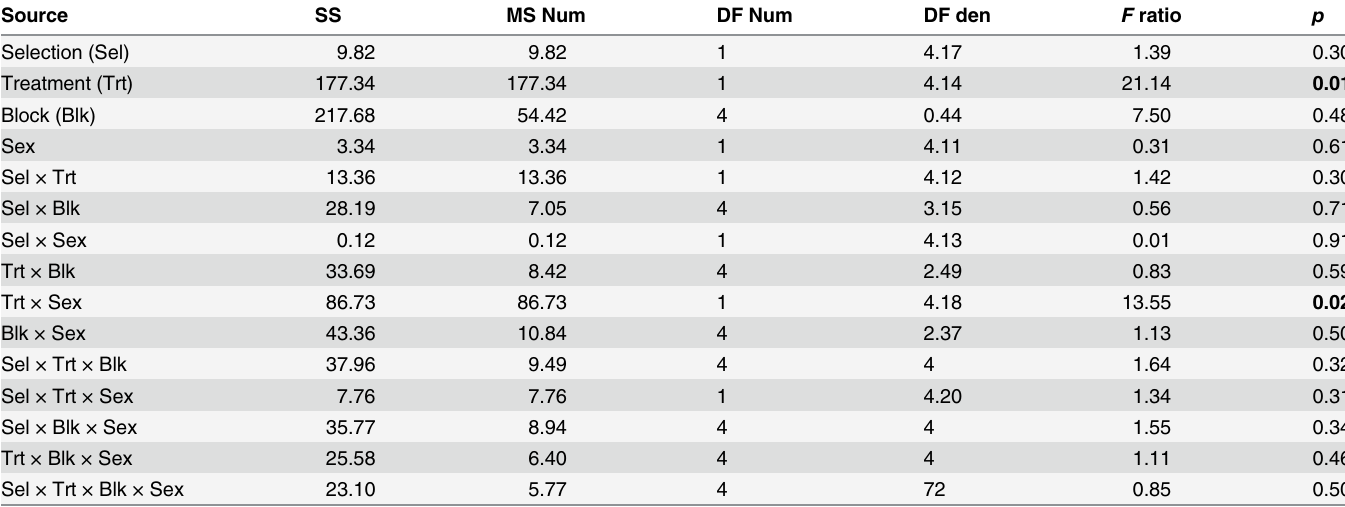
Table 3. Effect of cold shock on adult mortality (Experiment